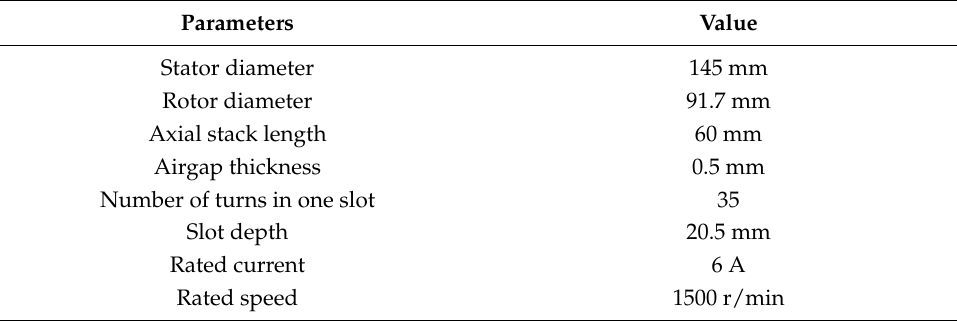
Table 1. Main parameters of the fault-tolerant PM